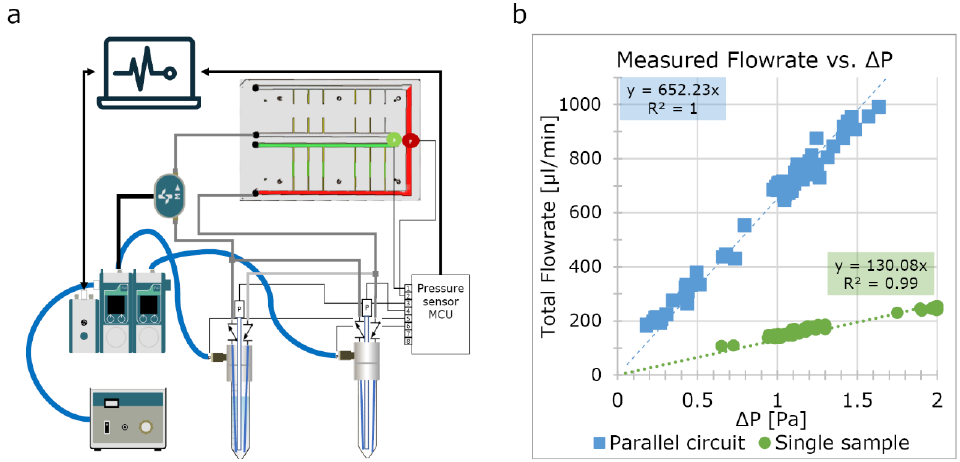
Figure 6. Flow rate vs. pressure difference. ( a ) Schematic of the used fluidic circuit shows the FCB with 6 channels connected. The free channels were blocked using a dummy chip. ( b ) Pressure difference relationship for a single channel (green plot) and six channels in parallel (blue plot). The measurements show correlation with the predicted values (Figure S4); however, the six channels in parallel show a 5-fold increase in flow rate dependence but this can be attributed to the tolerances of the fabricated FCB.